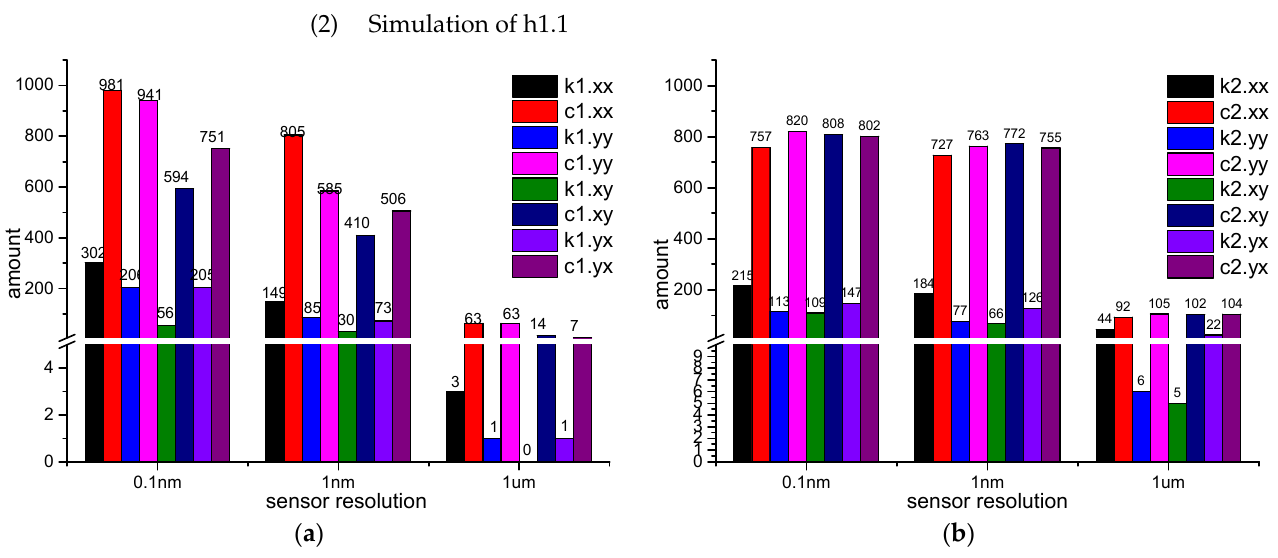
Figure A12. Statistical results of the amount of the frequencies, at which the related error is less than 10% and the absolute value is less than 10: ( a ) #1 bearing; ( b ) #2 bearing.